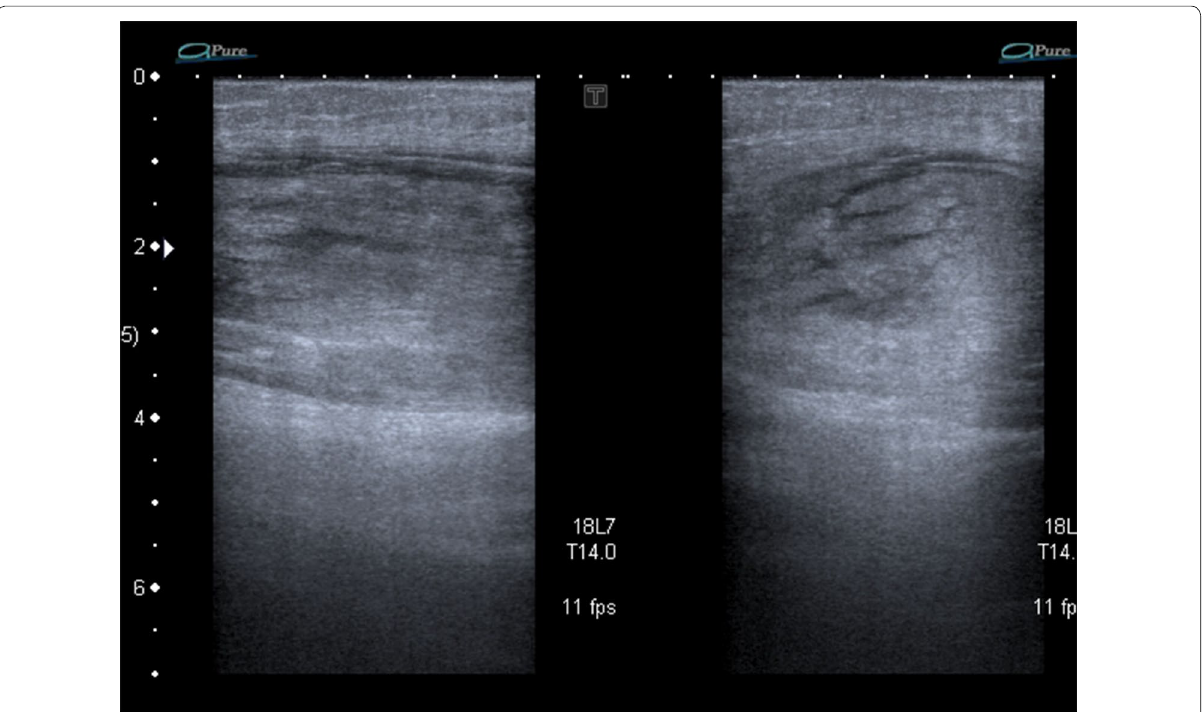
Fig. 3 Hyperechoic, oedematous appearance in the sartorius muscle belly